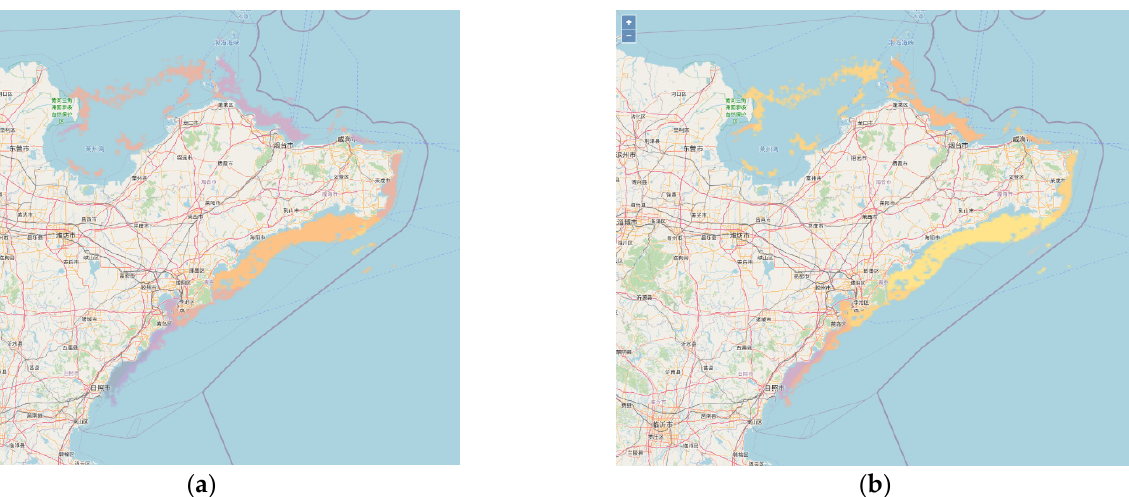
Figure 6. Comparison between ( a ) the assessment results without the coupled strengthening effect; and ( b ) the assessment results with the coupled strengthening effect.